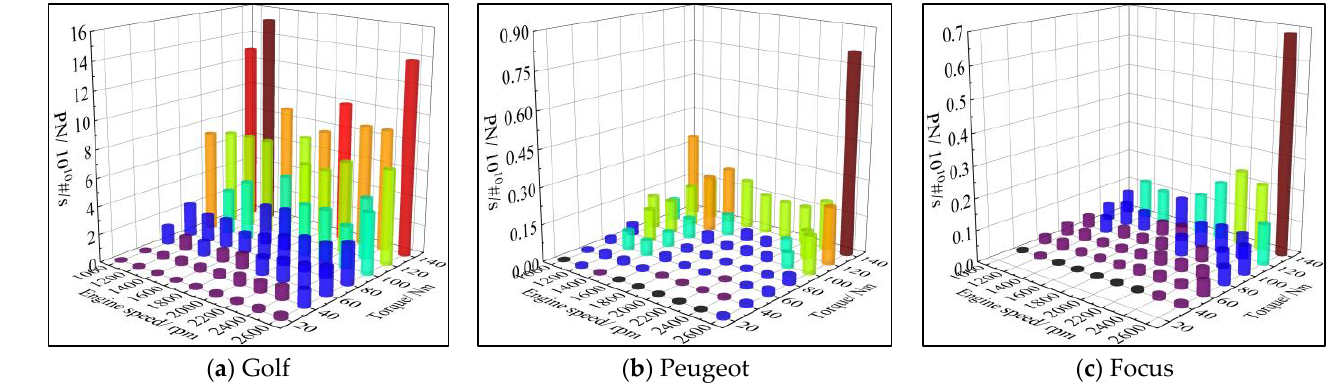
Figure 6. PN emission rates vs. engine speed and torque.